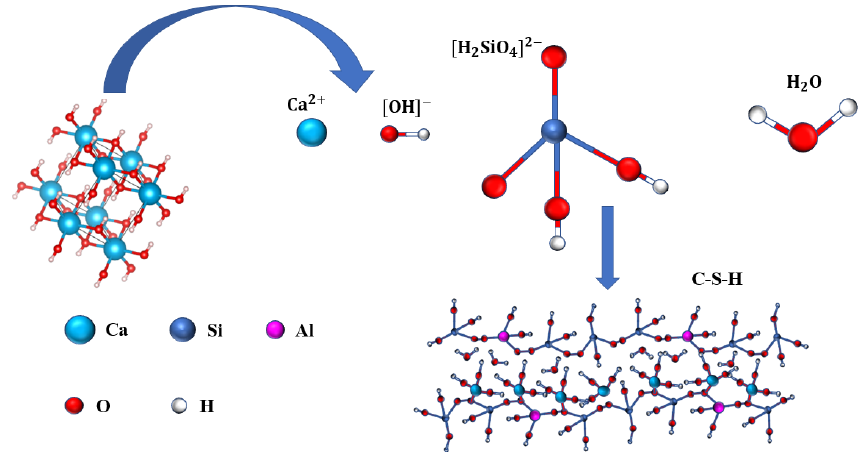
Figure 9. Molecular structure models of the microporous calcium silicate hydrate.